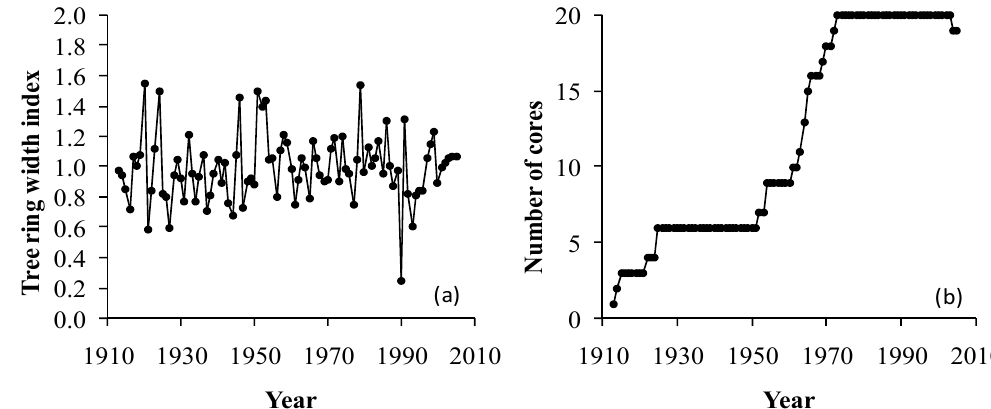
Figure 2. Timeseries of tree-ring width index (TRWI) ( a ) and available number of tree cores per year ( b ).